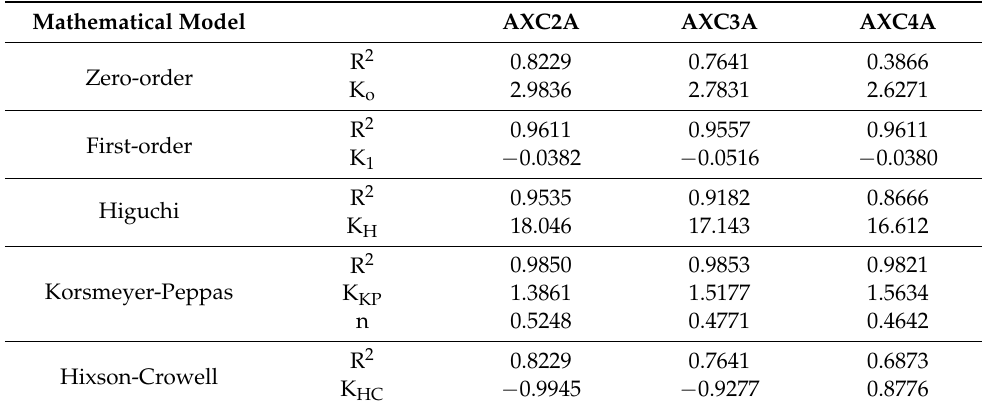
Table 3. Amikacin release kinetics from AX-CMC composite